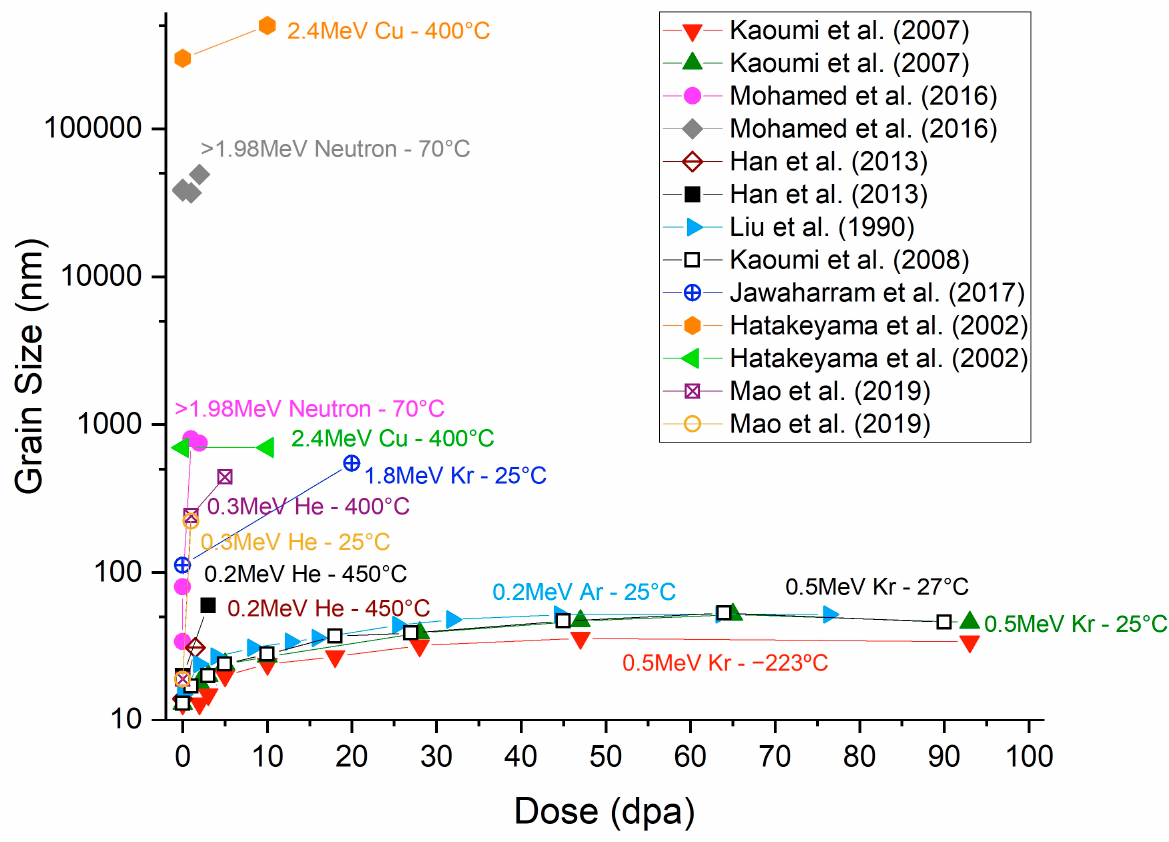
Figure 1. Grain size of irradiated pure Cu as a function of irradiation dose [9,12,22,31,32,34,50,51]. To deconvolute the complex grain growth phenomena caused by combinations of irradiation and thermal exposure, Kaoumi et al. identified three grain growth regimes